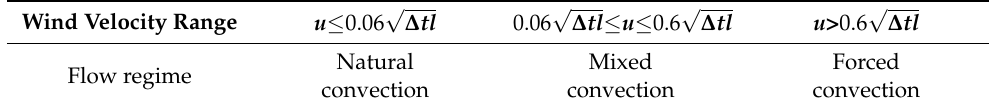
Table 1. Wind velocity ranges and flow regimes.